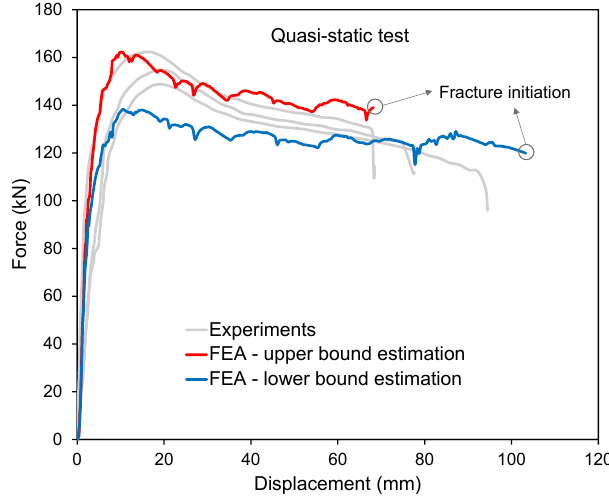
Figure 7. Force-displacement curves for quasi-static